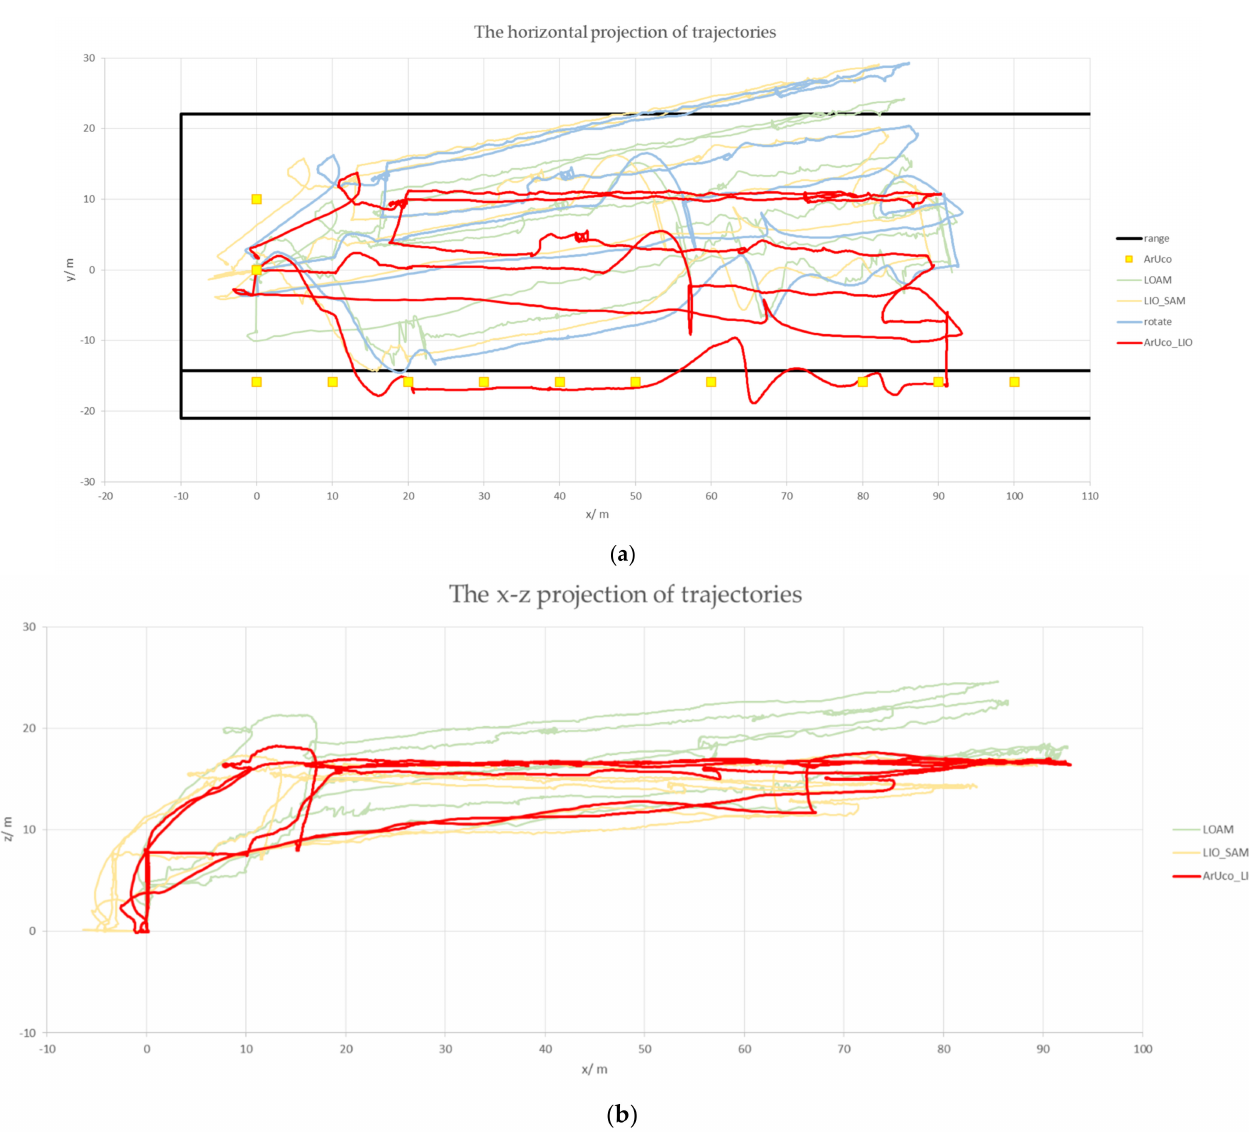
Figure 11. The trajectory calculated by each navigation system. ( a ) is the horizontal projection of the trajectory; ( b ) is the x-z projection of the